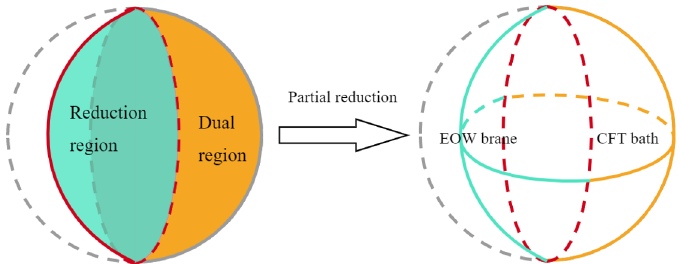
Figure 12 . The partial reduction procedure of global AdS on a time slice. For AdS 5 , a time slice of the BCFT 4 is defined on a 3 d hemisphere with a S 2 boundary.